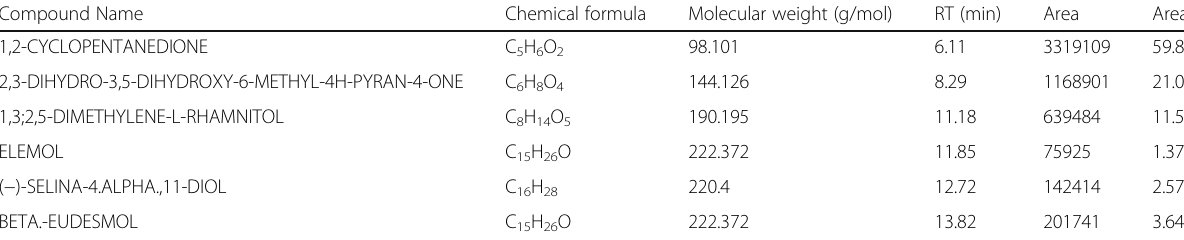
Table 3 Compounds identified in in BG seed methanol extract using GC-MS